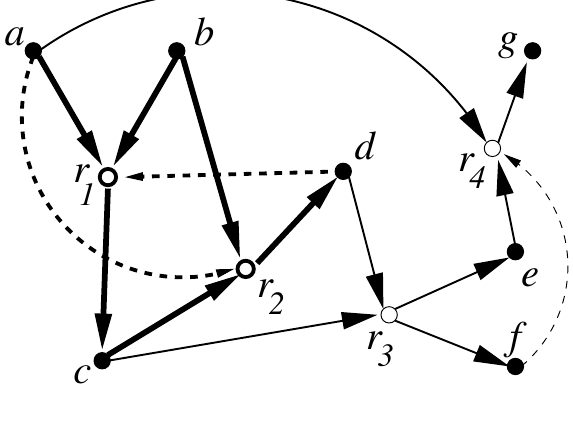
Figure 1. A simple example of a catalytic reaction system (CRS) with seven molecule types { a, b, c, d, e, f, g } (solid nodes) and four reactions { r set is F = { a, b } . Solid arrows indicate reactants going into and products coming out of a reaction, dashed arrows indicate catalysis. The subset R = { r arrows) is